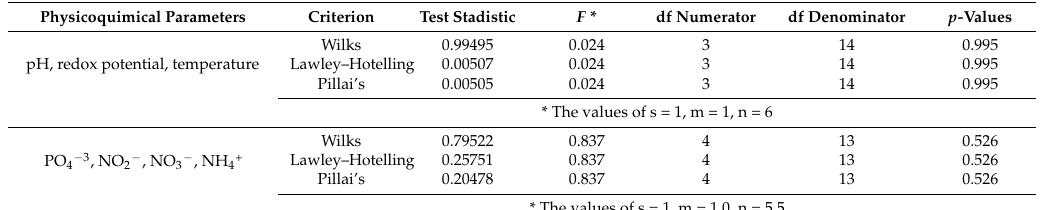
Table 1. Multiple analysis of variance (MANOVA) output of physicochemical parameters of pore water tanks during the afforestation and conditioning stage with Rhizophora mangle (Phase 2) ( p < 0.05). Physicoquimical Parameters Criterion